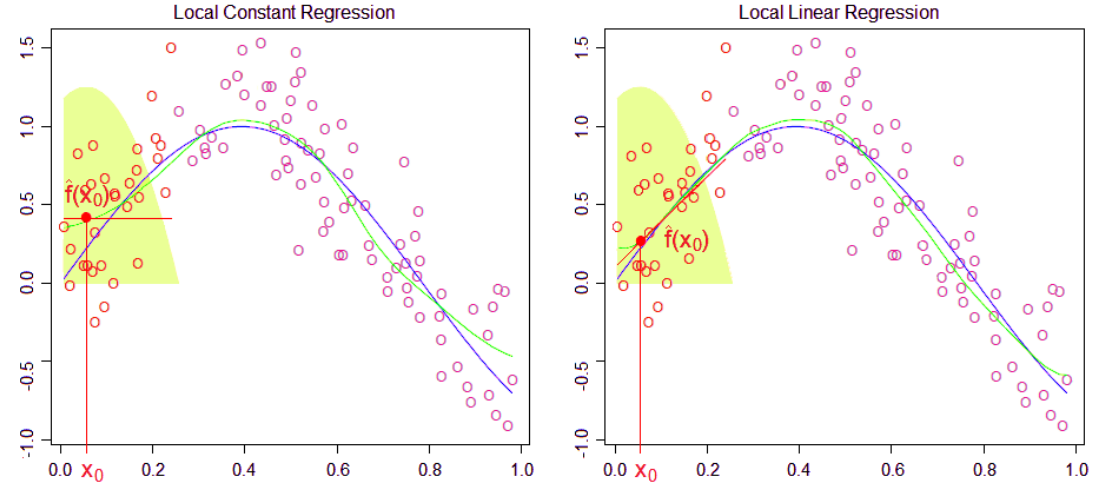
Figure 6. LC and LL kernel regression using the Epanechnikov kernel with λ = 0.2 in one dimension Figure 6. Locally constant (LC) and LL kernel regression using the Epanechnikov kernel with λ = 0.2 in one